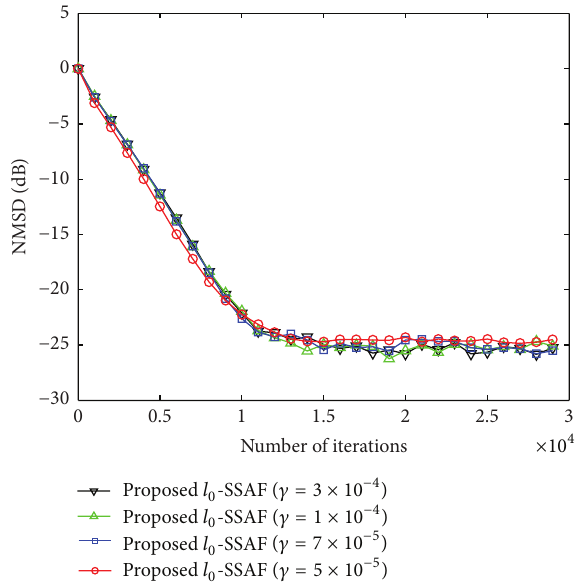
Figure 3: NMSD learning curves of the 𝑙 0 -SSAF algorithm with various 𝛾 values [ 𝑁 = 4 , SIR = −30 dB, input: Gaussian AR (1) with pole at 0.9].